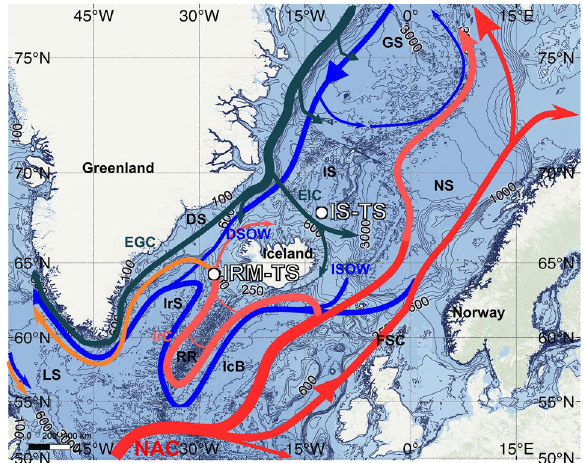
Figure 1. Map of the subarctic Atlantic showing the main surface and deep currents. The locations of the Iceland fixed station (IS-TS) and Irminger fixed station (IRM-TS) described in this study are indicated by white dots. A schematic diagram of the large-scale circulation of the main water masses is shown: North Atlantic Current (NAC), Irminger Current (IrC), East-Icelandic Current (EIC), East Greenland Current (EGC) Denmark Strait Overflow (DSOW) and Iceland Scotland Overflow Water (ISOW). Some geographical features are also shown: Labrador Sea (LS), Irminger Sea (IrS), Iceland Basin (IcB), Greenland Sea (GS), Iceland Sea (IS), Norwegian Sea (NS), Reykjanes Ridge (RR), Denmark Strait (DS) and Faroe-Scotland Channel (FSC). Schematic diagram of the large-scale circulation is adapted from Våge et al. 34 and Lherminier et al. 36